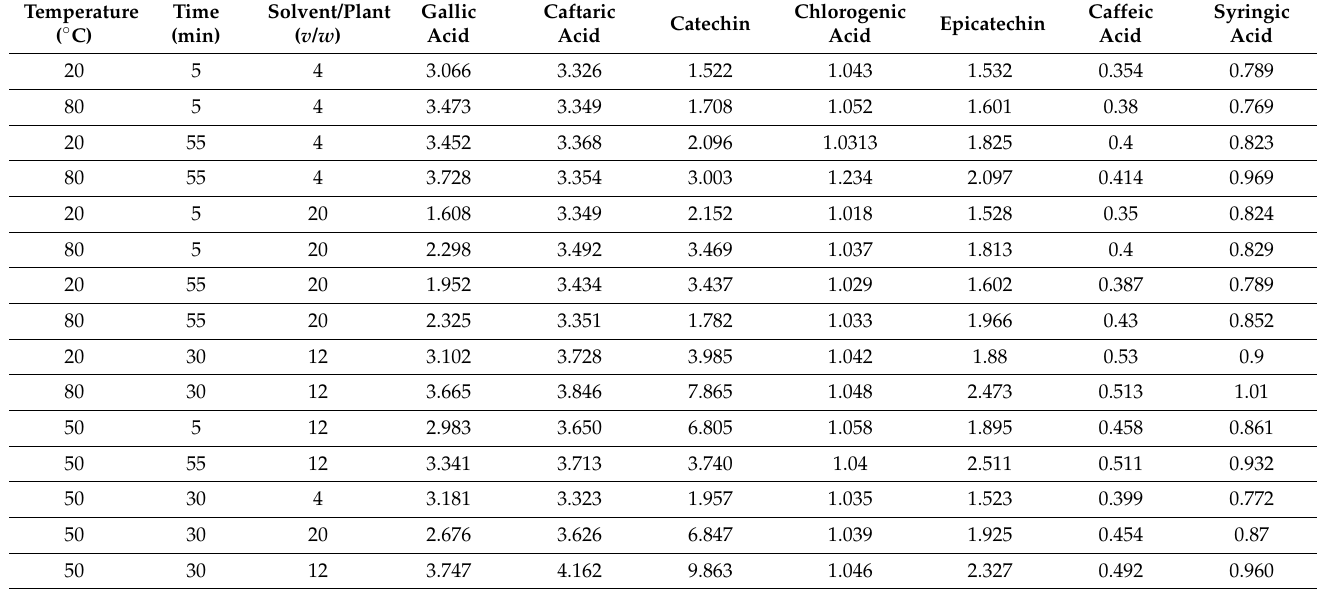
Table 1. Design of the experimental matrix with resulting experimental data for detected metabolites.